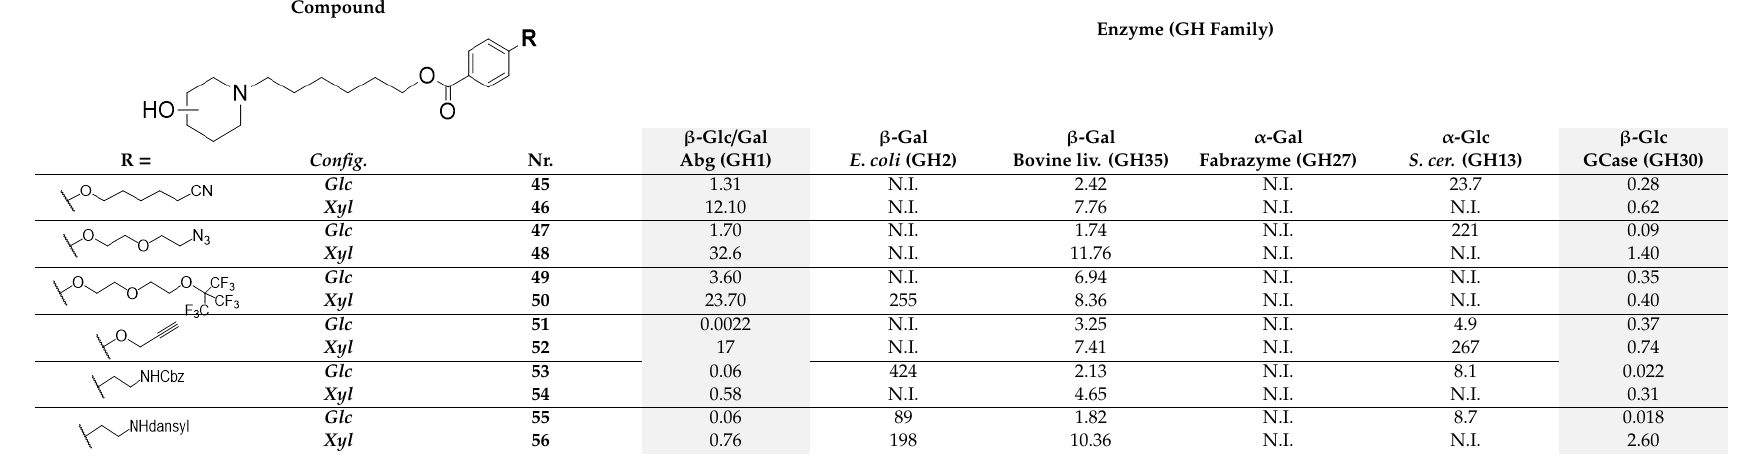
Table 1. K i -values [µM] of compounds 45 – 56 with Abg = β -glucosidase/ β -galactosidase from Agrobacterium sp.; E. coli = lac Z β -galactosidase from E. coli ; Bovine liv. = β -galactosidase from bovine liver; Fabrazyme = commercial recombinant human lysosomal α -galactosidase; S. cer. = α -glucosidase from Saccharomyces cerevisiae ; GCase = recombinant human lysosomal β -glucocerebrosidase; N.I. = no or weak inhibition, with K i > 1 mM;